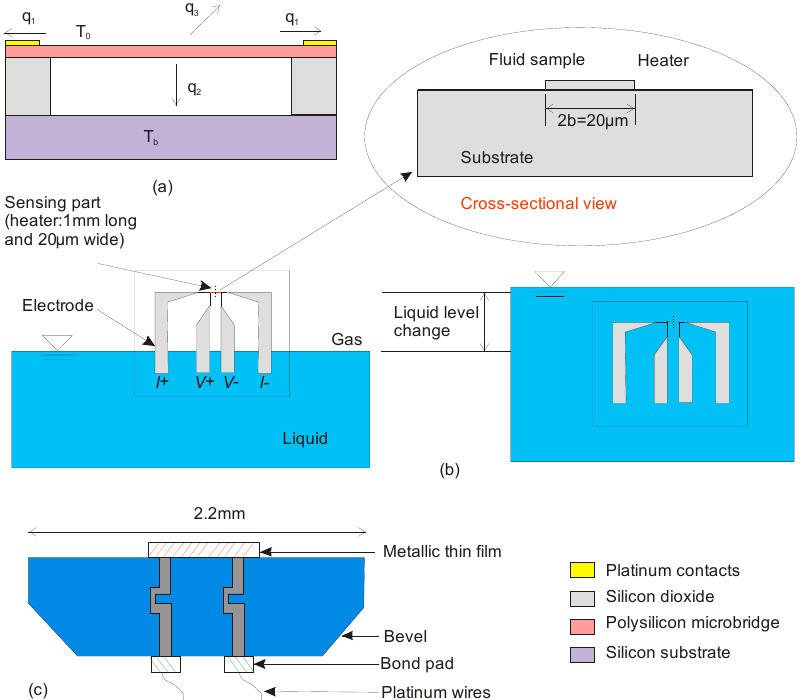
Figure 10. Examples of recently reported thermoresistive flow sensors, ( a ) A polysilicon micro-bridge based thermal gas flow sensor; ( b ) A volumetric thermal flow sensor for automotive fuel injection; ( c ) Schematic diagram of the operation of a point level sensor. The sensor detects the fluid phase at a specific location by measuring the temperature change of the heater where I+ and I − indicates electric current supply and V+ and V − indicates 3 ω voltage output respectively.